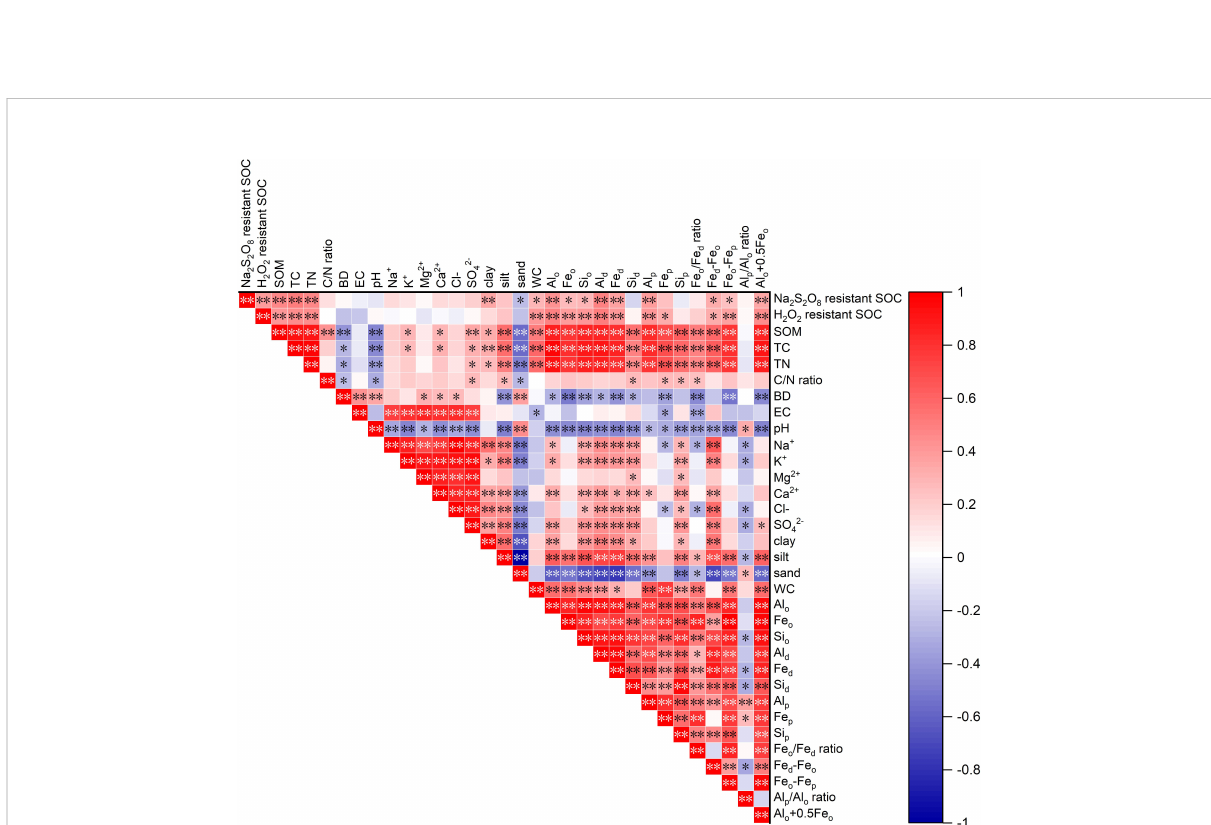
FIGURE 6 Correlation matrix of the two stabilized SOC fractions with Al/Fe/Si oxides, mineral phase indicators and soil properties. [*Correlation is signi fi cant at p < 0.05 level (2-tailed); **Correlation is signi fi cant at p < 0.01 level (2-tailed)].